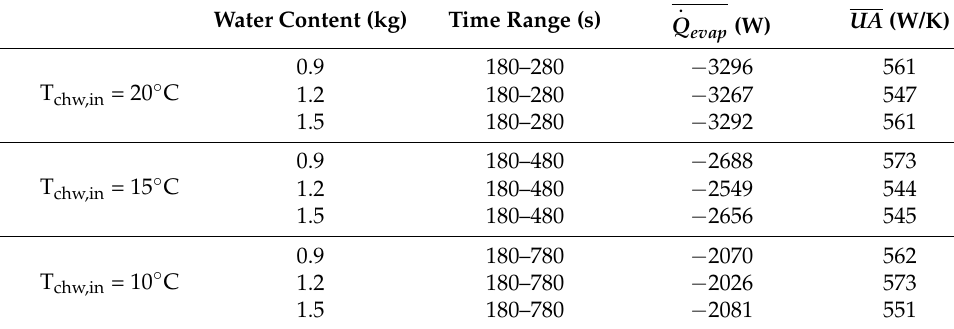
Figure 4. Evaporation power and UA trends by varying inlet chilled water temperature and water content inside the evaporator. Table 4. Evaporation exchanged power and UA average plateau values.